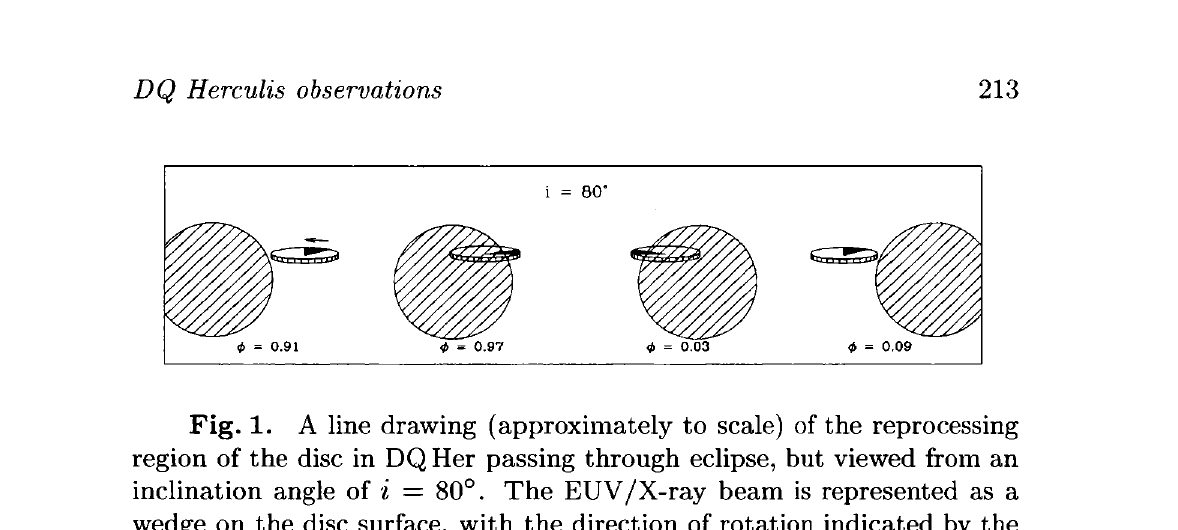
Fig. 1. A line drawing (approximately to scale) of the reprocessing region of the disc in DQ Her passing through eclipse, but viewed from an inclination angle of % = 80°. The EUV/X-ray beam is represented as a wedge on the disc surface, with the direction of rotation indicated by the arrow. The accreting white dwarf is located at the apex of the wedge. Dur- ing ingress (egress) the reprocessed pulses will arrive earlier (later) than when out of eclipse. Note that the non-zero disc opening angle results in a front/back asymmetry in the visibility of the disc surface. For inclinations greater than i = 90° — (0) « 86°, the white dwarf is permanently eclipsed by the edge-on, optically-thick accretion